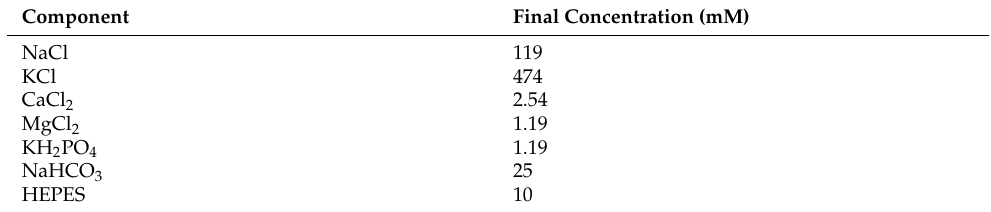
Table 3. Composition of Krebs Ringer Bicarbonate Buffer including 0.2% bovine serum